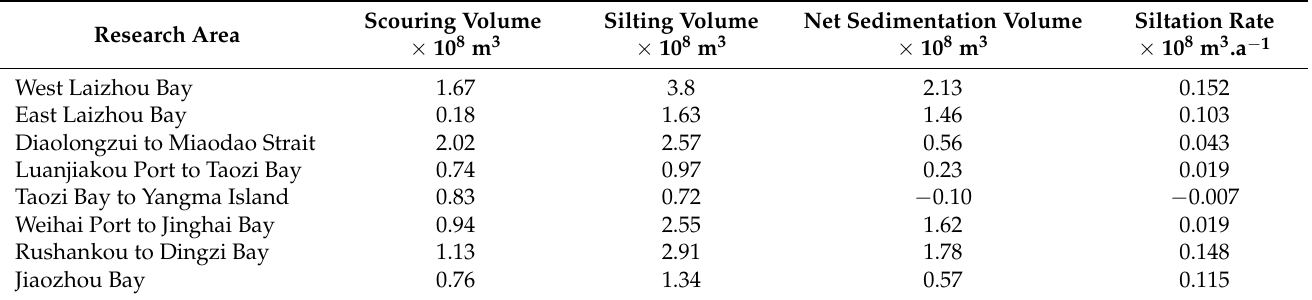
Table 3. Regional scouring–siltation